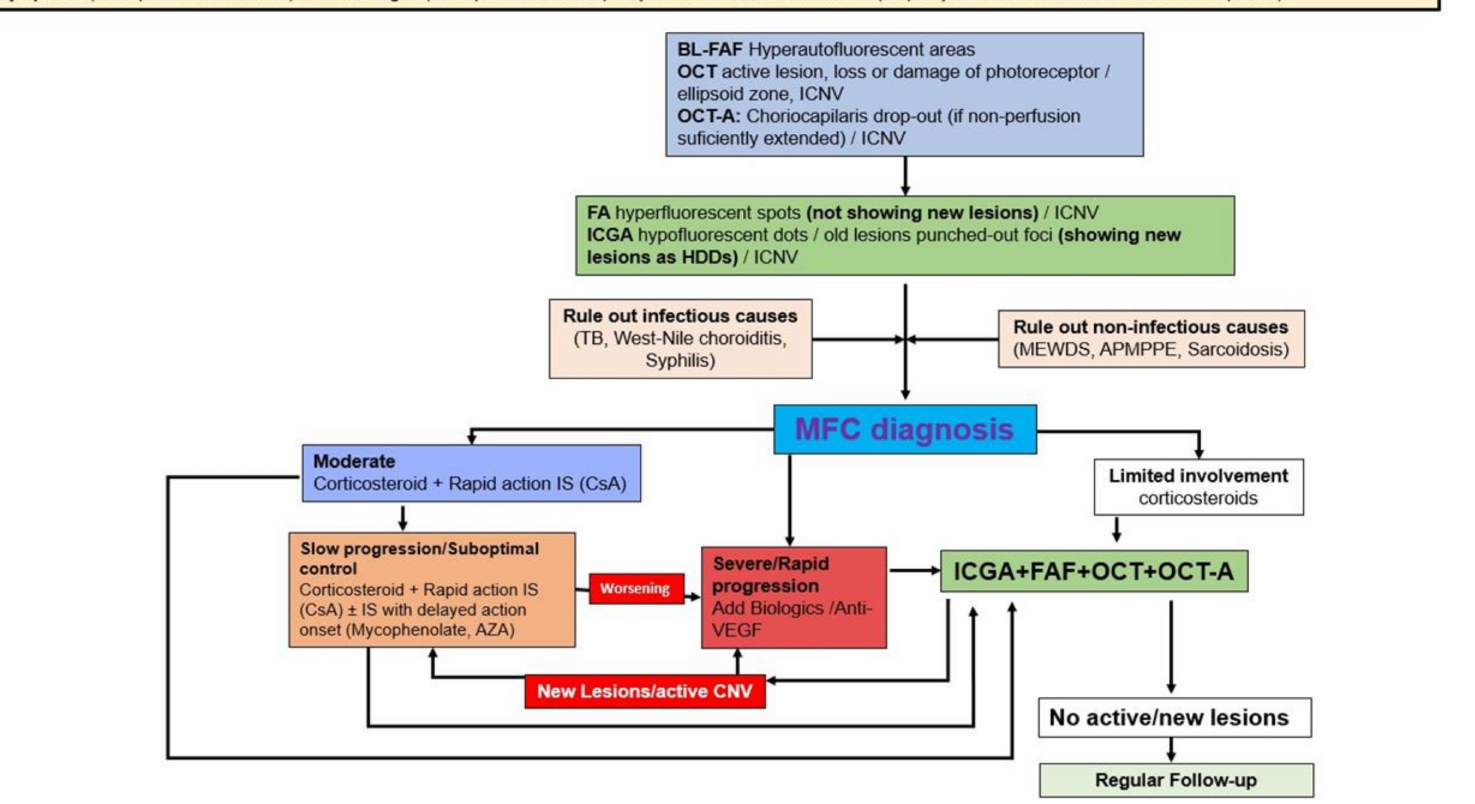
Scheme 3. Appraisal of MFC: decision tree in clinical practice. PP: posterior pole. OCT: optical coherence tomography. iCNV: inflammatory choroidal neovasculariza- tion. BL-FAF: blue light autofluorescence. OCT-A: OCT-angiography. FA: fluorescence angiography. ICGA: indocyanine green angiography. HDDs: hypofluorescent dark dots. TB: tuberculosis. MEWDS: multiple evanescent white dots syndrome. APMPPE: acute posterior multifocal placoid pigment epitheliopathy. MFC: idiopathic multifocal choroiditis. IS: immunosuppressors. CsA: Cyclosporine. AZA: